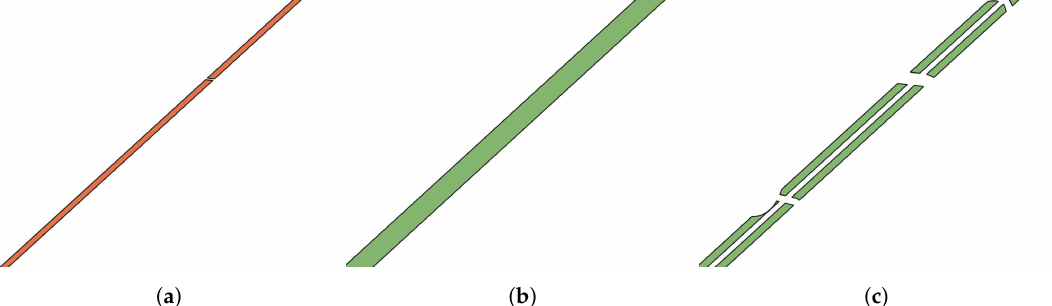
Figure 5. Example of the phases to create the outer buffers. ( a ) Polygon that represents a Fuel Management Zones (FMZ) along electrical lines, with a width of 15 m. ( b ) Polygon resulting from using the 20 m Buffer function. ( c ) Polygons that represent only external areas of the FMZ, after removing the middle of the FMZ and roads from